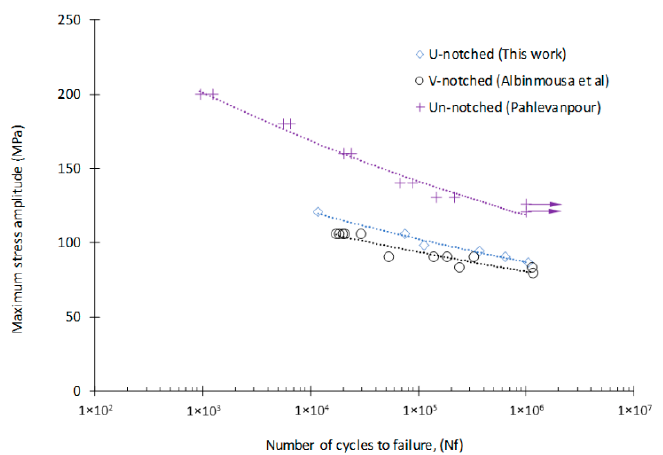
Figure 9. Effects of a notch and the notch geometry on fatigue life [34]. Reproduced from [34], with permission from Elsevier, 2020.